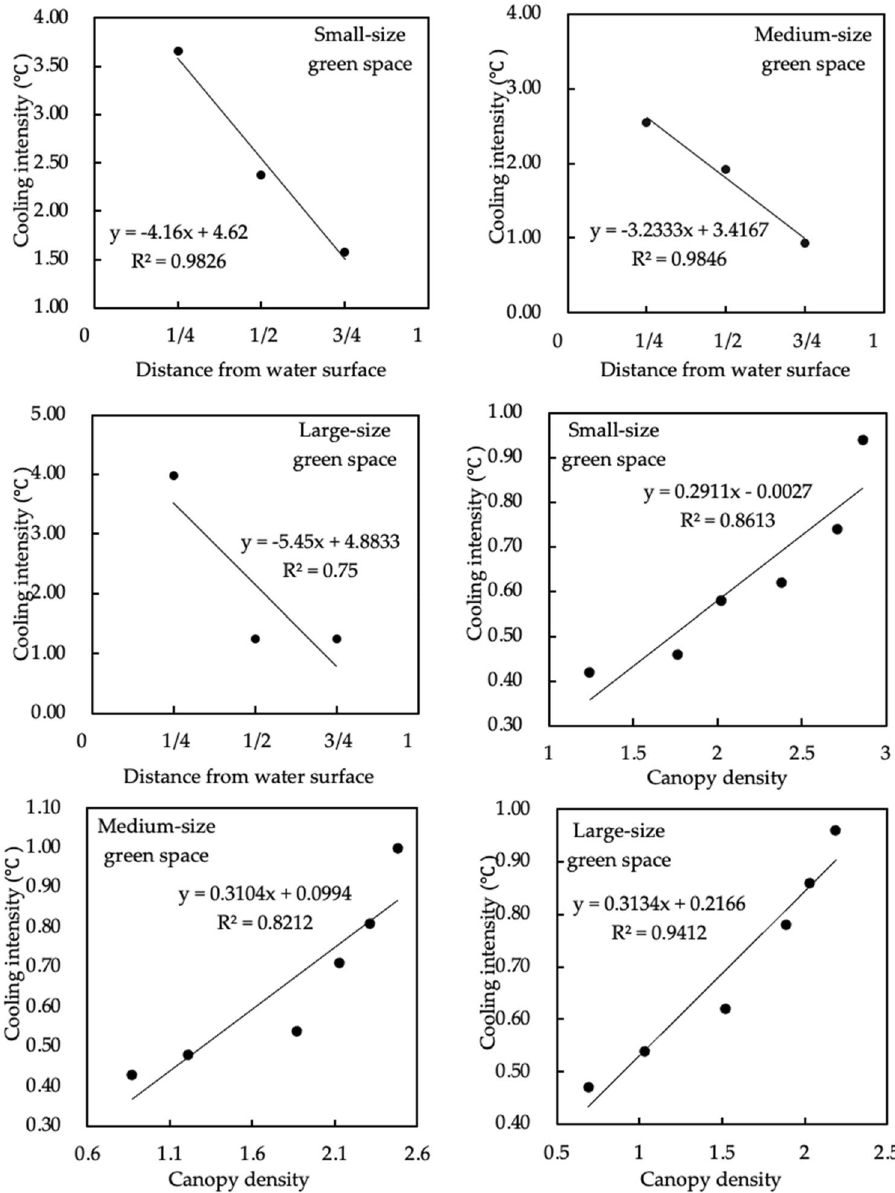
Figure 13. Linear regressions between the distance from different types of green spaces to water areas, canopy density and cooling